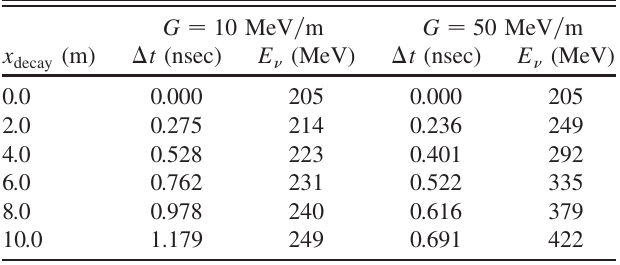
¼ 350 MeV at injection into PILAC. The TABLE I. For T (cid:3) E here are for the higher of the two neutrino energies shown in (cid:1) Fig.